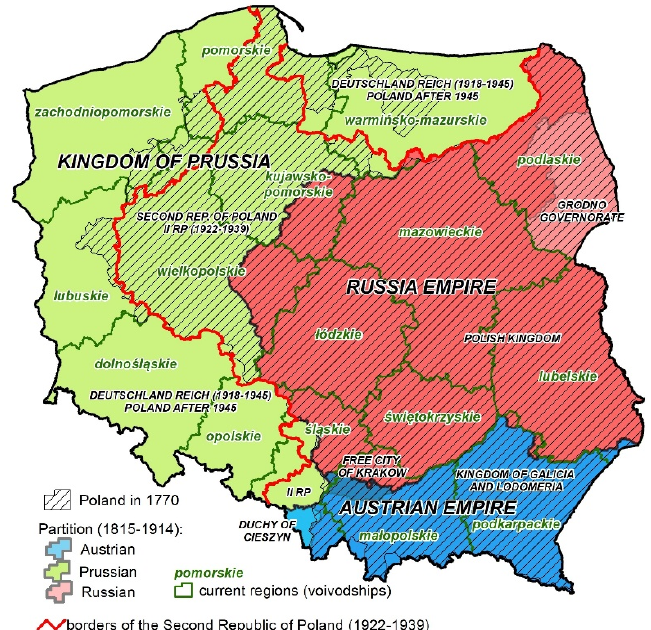
Figure 1. Layout of former political borders vs. the present territory of Poland. Source: own elabo- ration.